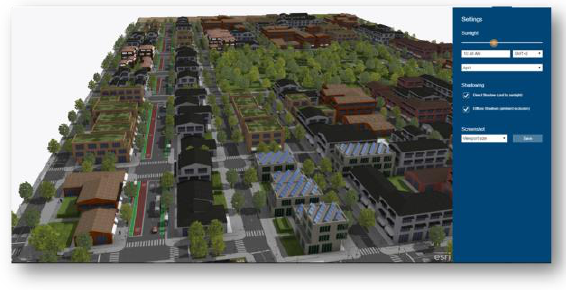
Figure 14. Simulation of shadow analysis